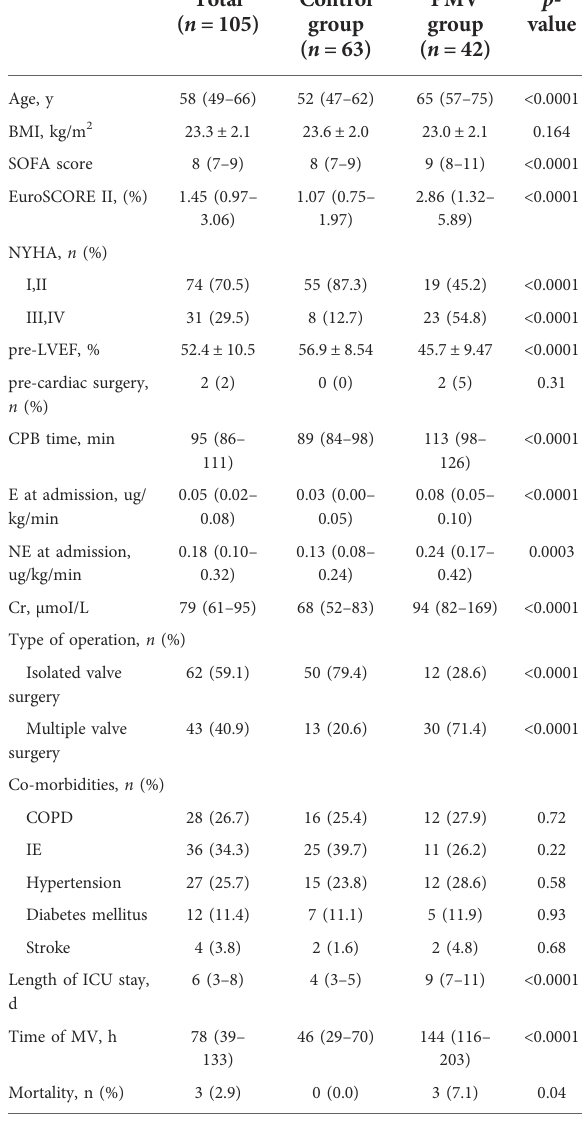
TABLE 1 Baseline characteristics of the patients after cardiac valve